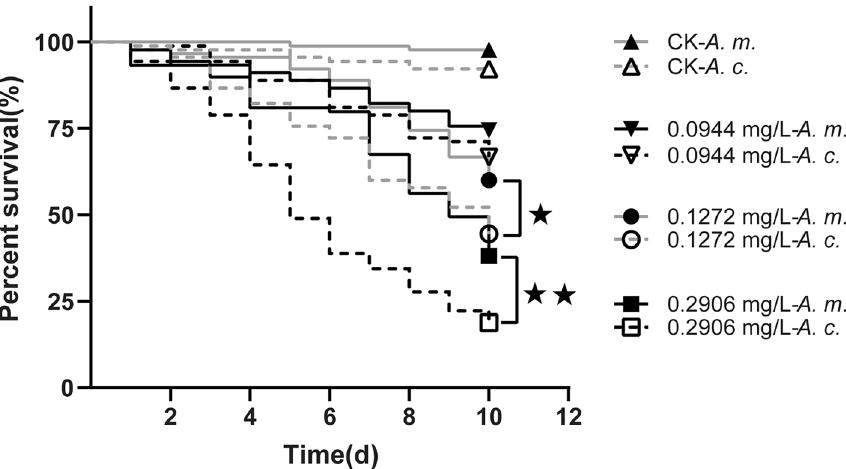
Figure 4. Survival risk analysis of beta-cypermethrin on A. m. ligustica and A. c. cerana . Based on our results for pesticide residue detection in honeybee nationwide, three concentrations were selected for beta- cypermethrin (Median, the median value of all samples; Mean, the mean value of all samples; Max, the maximum of all samples) as follow: 0.0944, 0.1272 and 0.2906 mg/L. Solvent treatment (acetone) served as blank control. Line with one star is significant different at P < 0.05 and two stars are significant different at P <